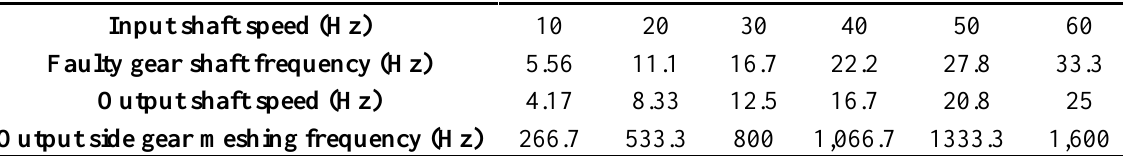
Table 1. Output shaft speed corresponding to input shaft